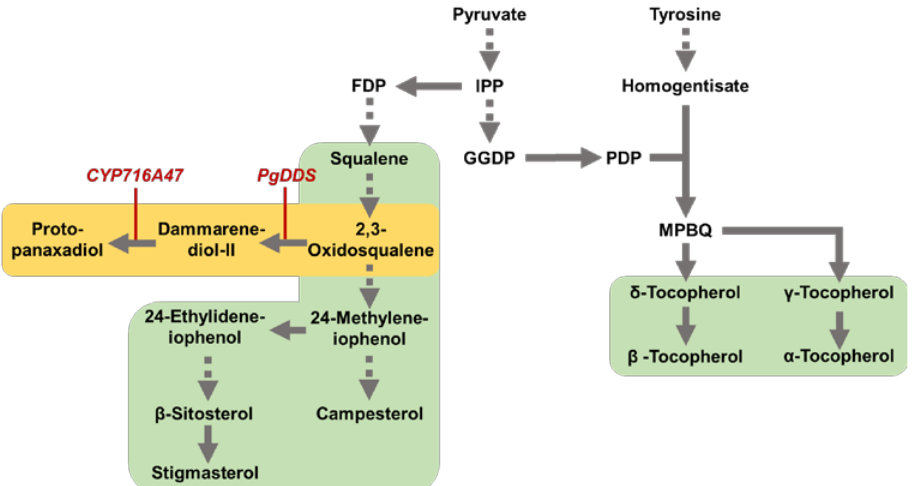
Figure 4. Biosynthetic pathway for protopanaxadiol, phytosterols, and tocopherols. Abbreviations: IPP, isopentenyl diphosphate; FDP, farnesyl diphosphate; GGDP, geranylgeranyl diphosphate; PDP, phytyl diphosphate; MPBQ, 2-methyl-6-phytyl-1,4-benzoquinol.